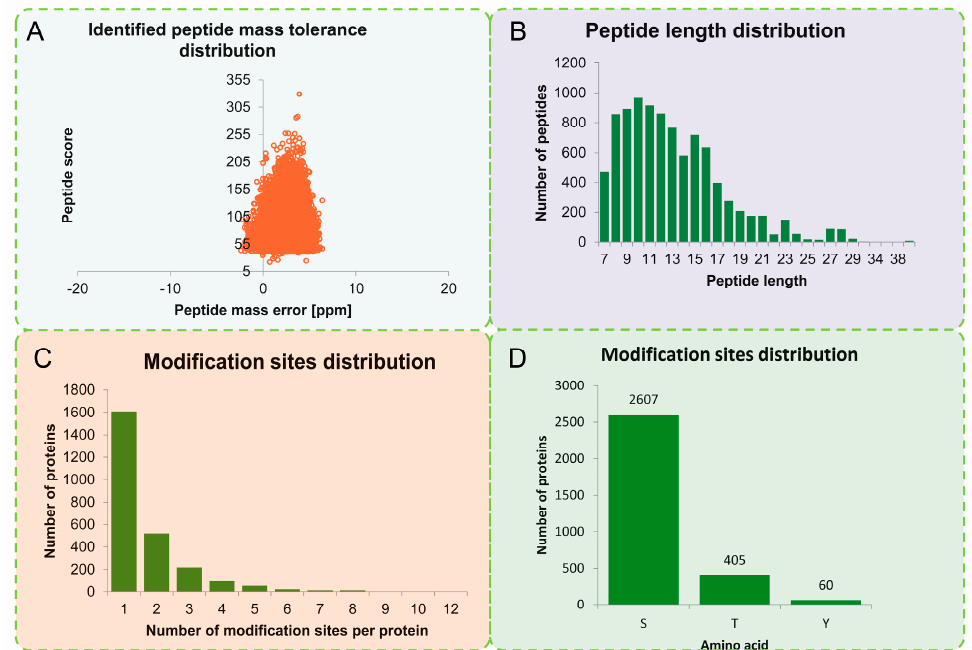
Figure 1. Quality control (QC) validation of mass spectrometer (MS) data. ( A ) Mass error distribution of all identified phosphorylated peptides. ( B ) Length distribution of all identified phosphorylated peptides. ( C ) Modification phosphorylated sites distribution of all identified peptides. ( D ) The distribution of phosphosites between serine (S), threonine (T), and tyrosine (Y) residues.